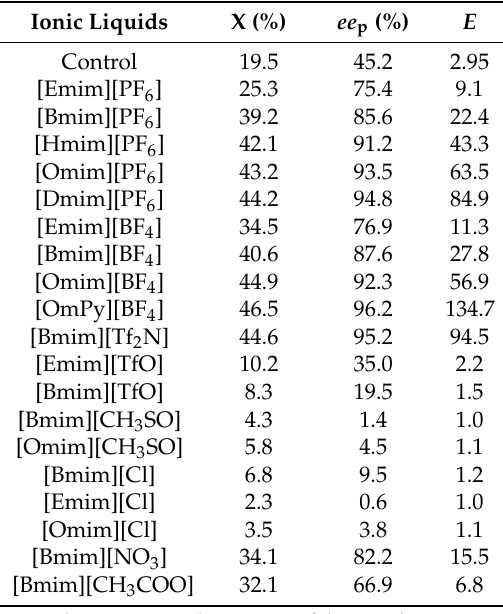
Table 1. Effect of ionic liquid on the enantioselective hydrolysis of ( R , S )-racemic ibuprofen ethyl ester by